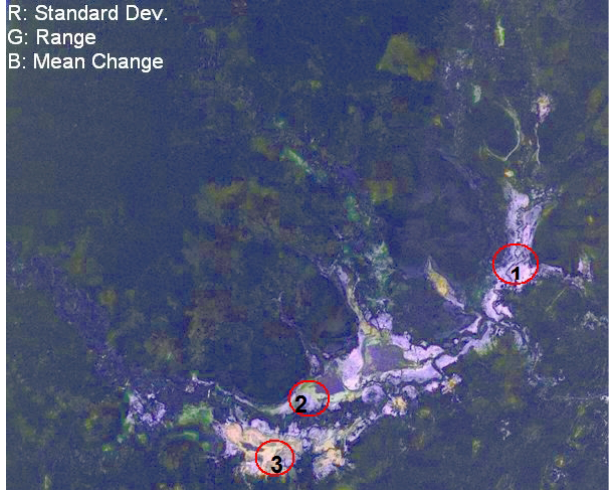
Fig. 7. Results of a temporal analysis of 20 PALSAR images col- lected in the period between 19 March 2007 and 27 September 2010. Light purple indicates the regularly inundated shrubland (1), green indicates reeds/sedges (2), yellow at the southern lake indi- cates rice growing areas in years when flooding is not too high (3).